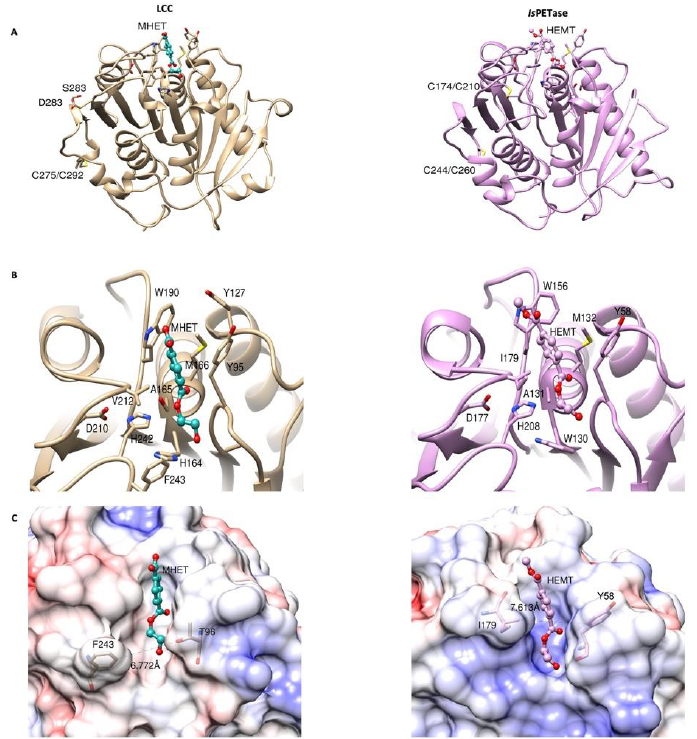
Figure 2. Complex structures of PET hydrolases with MHET and 1-(2-hydroxyethyl) 4-methyl terephthalate (HEMT). ( A ) Model representations of LCC/MHET ( left ) and Is PETase-S131A/HEMT ( right ). Two disulfide bridges are shown in Is PETase and one disulfide bridge in LCC. ( B ) View of the enzyme-substrate interaction network for both enzymes and catalytic residues. ( C ) Substrate-binding cleft of LCC and Is PETase, shown with coulombic electrostatic surface (blue is a positive charge and red is a negative charge). The dashes indicate the width of the substrate-binding cleft. To obtain efficient PET bio-recycling tools, currently, the best enzyme candidates for improvement, by means of protein engineering, seem to be the thermostable cutinases from Thermobifida fusca [45], Humicola insolens [46], Sacchamonosporas viridis [47] , LC-cu- tinase (LCC) [48], PHL7 or PES-H1 [49,50], BhrPETase [40], and some Is PETase variants